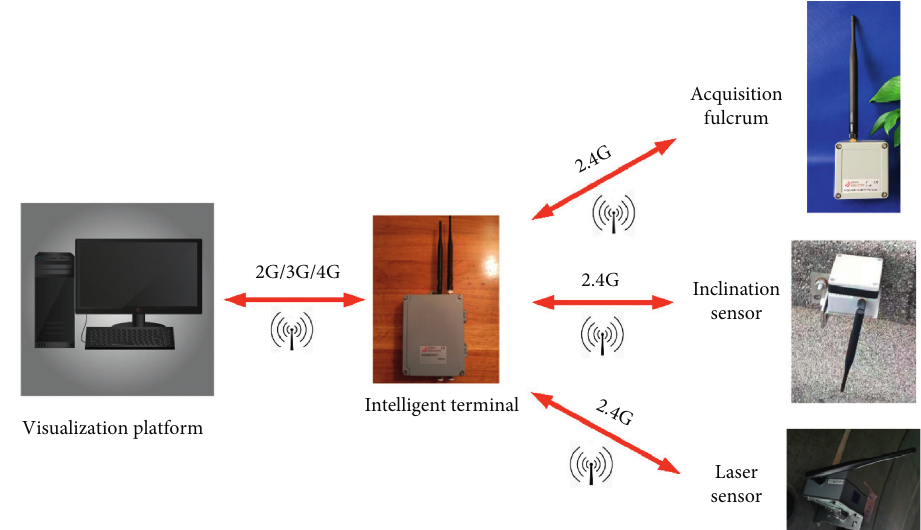
Figure 2: The MEMS sensors and schematic diagram of